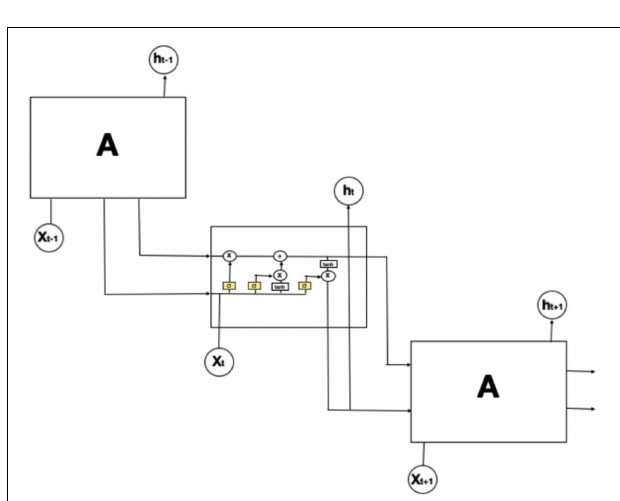
FIGURE 5 | The structure of long-short-term-memory (LSTM). The repeating module in an LSTM contains four interacting layers. In this figure, an LSTM model is expanded into 3-time steps (t–1, t, t+1). The middle box refers to the model at the current time with an input x t . Since LSTM is a recurrent neural network, it also obtains two outputs from the previous time step: the lower arrow is the short-term memory output (h t − 1 ) and the upper arrow is the long-term